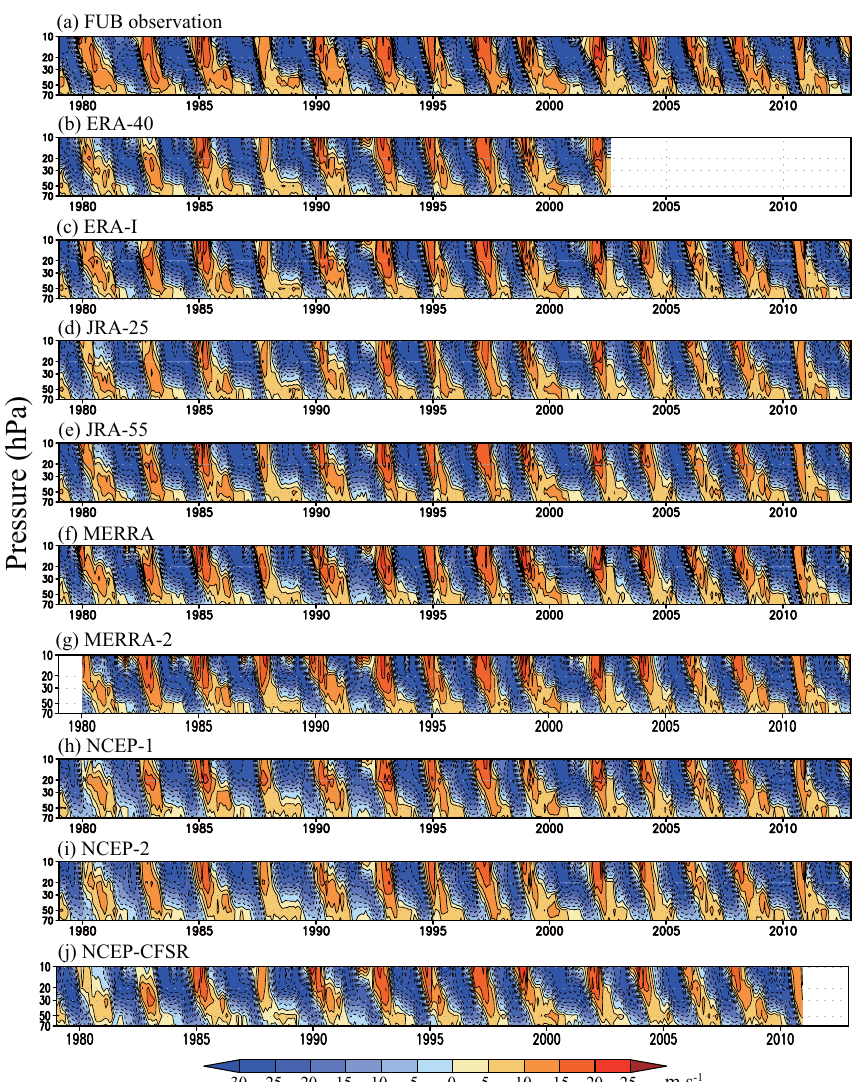
Figure 1. Time-height cross section of the FUB zonal wind and each reanalysis zonal wind over Singapore (104 ◦ E, 1.4 ◦ N) from 1979 to 2012. The color intervals are 5ms − 1